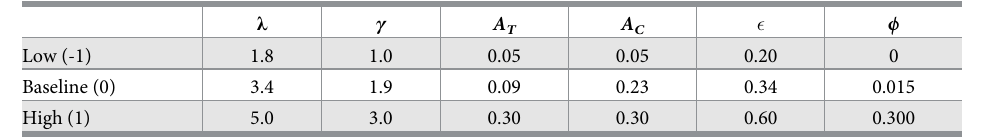
Table 2. Low and high geometric parameter